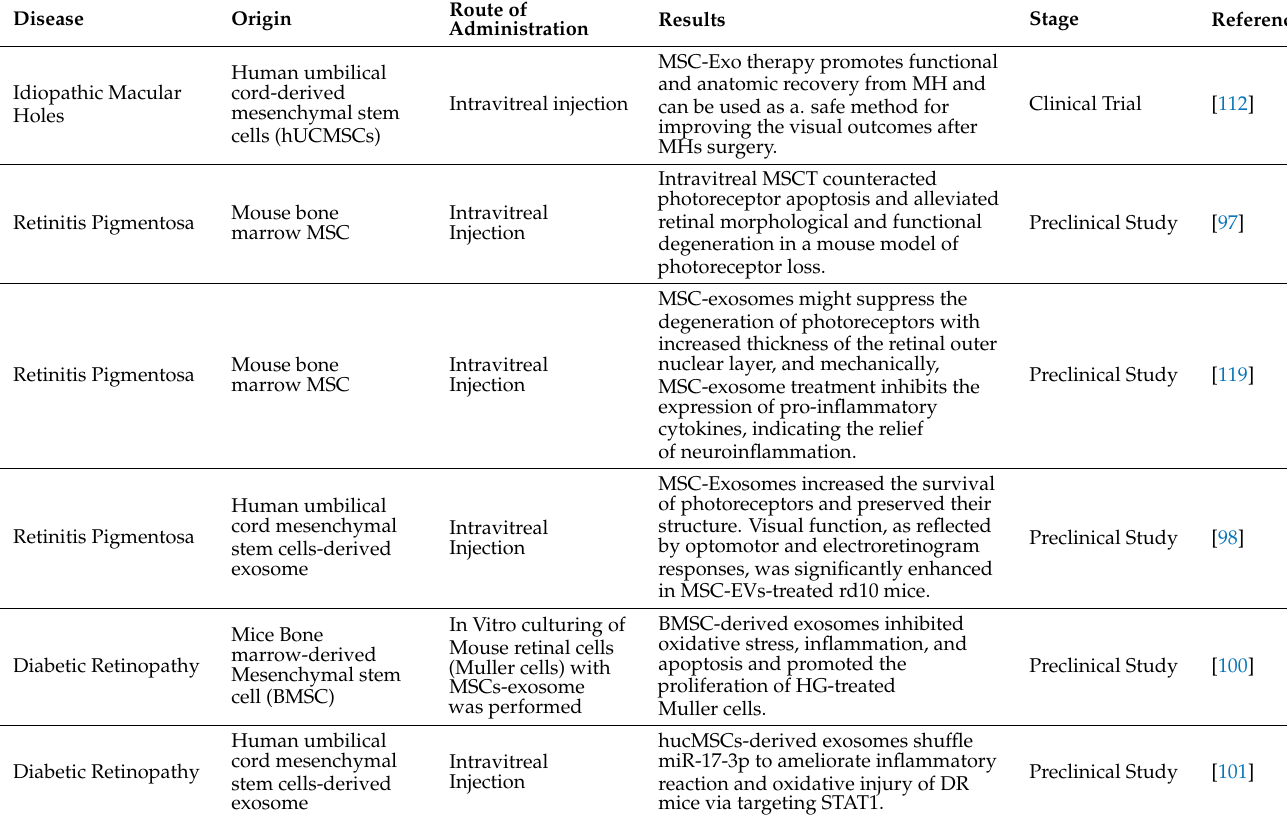
Table 2. MSC-derived exosomes in posterior segment diseases and